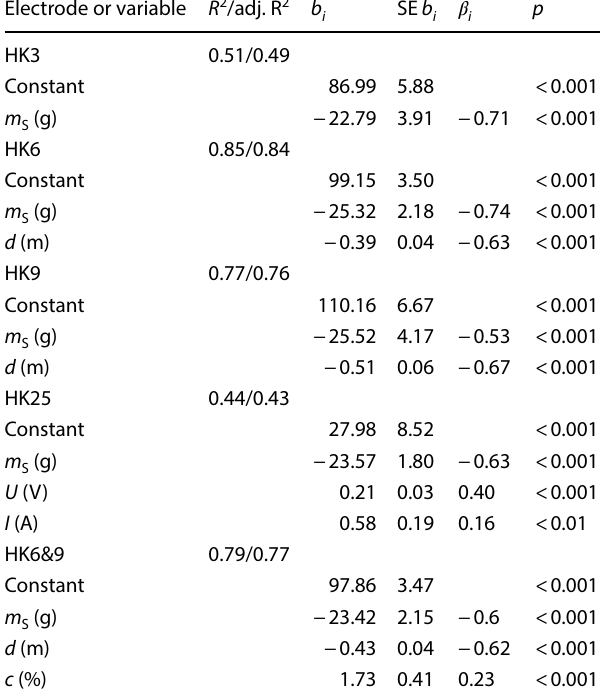
Table 3 Regression coefficients for each model: m deposited weld material, d is the water depth, U is the arc voltage, I is the welding current, c is the cellulose content of the electrode; SE stands for standard error Electrode or variable R 2 /adj. R 2 b i